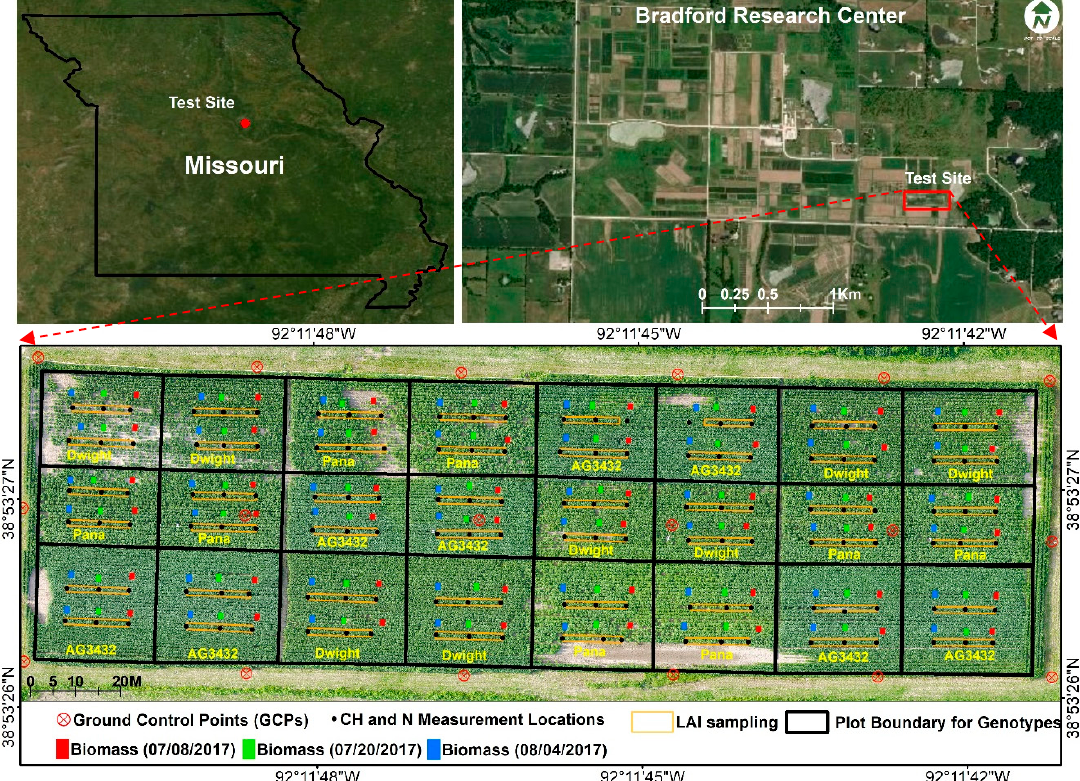
Figure 1. Geographical location and layout of the test field. The sampling locations of canopy height (CH) and leaf nitrogen concentration (N) are marked as black dots; the aboveground biomass (AGB) sampling locations on 8 July, 20 July, and 4 August are marked as red, green, and blue rectangles, respectively; khaki color rectangles are locations of leaf area index (LAI) measurement; the ground control points (GCPs) are marked as red circles with